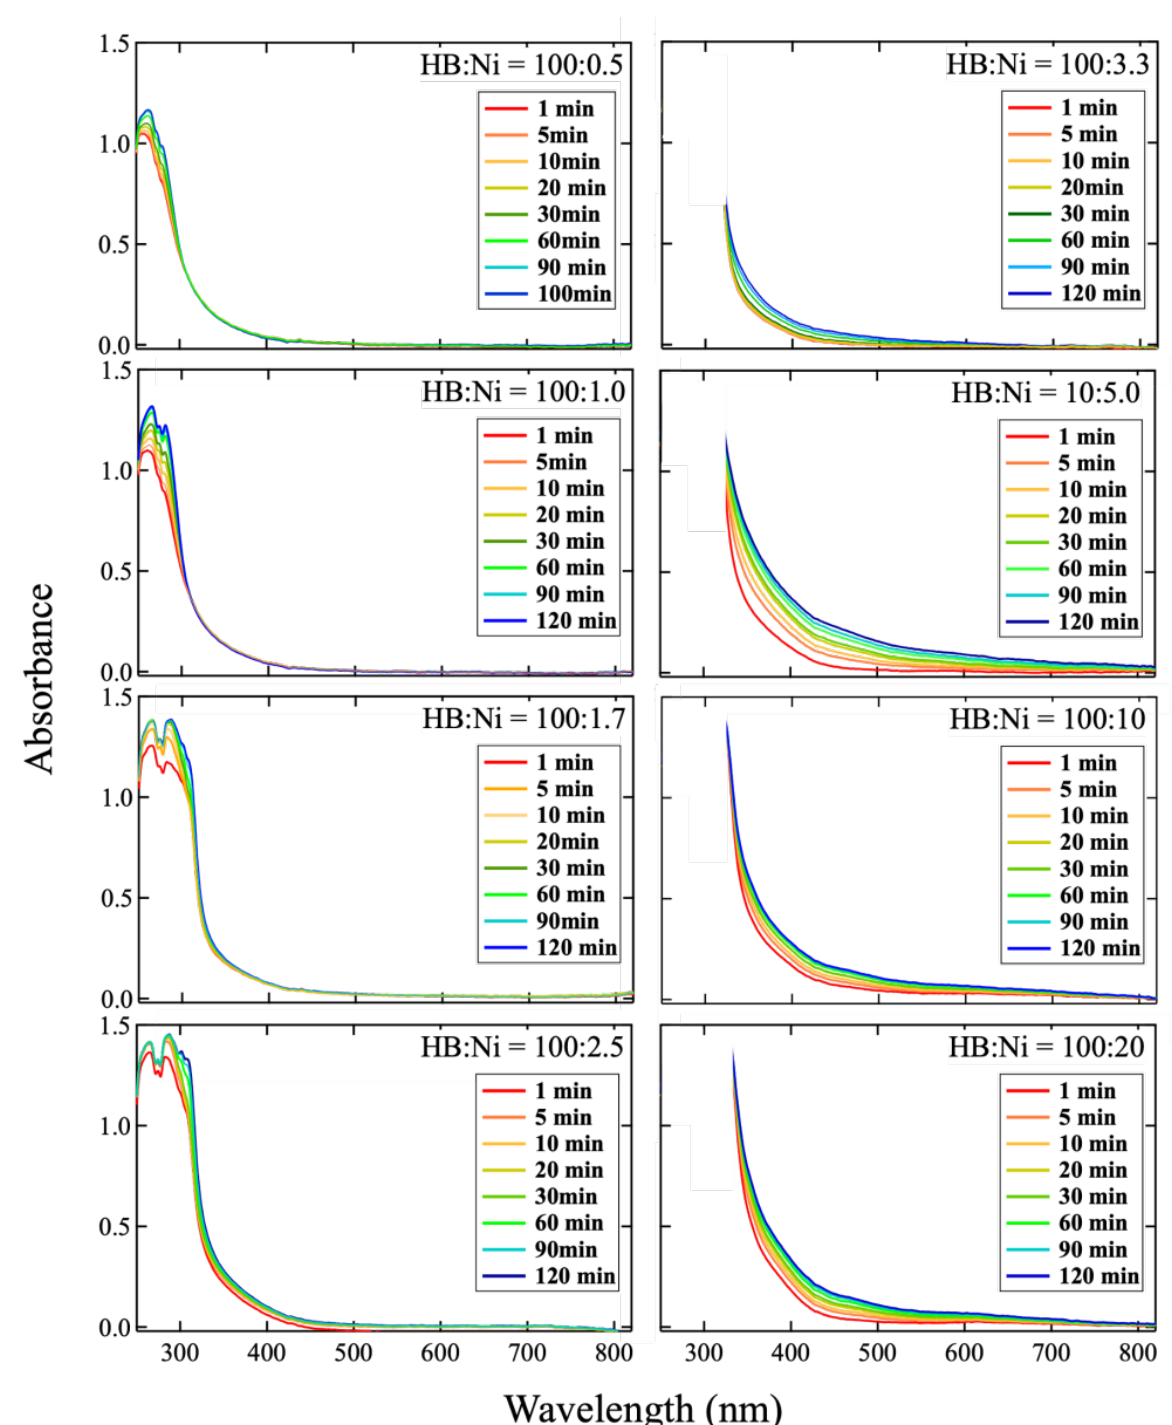
Figure 1. Temporal change in UV-vis spectra of HB dispersion at 0.02 mol/L in acetonitrile after mixing with Ni ions at various Ni ion concentrations. Molar ratio of the HB:Ni ions was adjusted from 100:0.5 to 100:20. Spectrum range under 330 nm for HB:Ni = 100:3.3, 100:5.0, 100:10, and 100:20